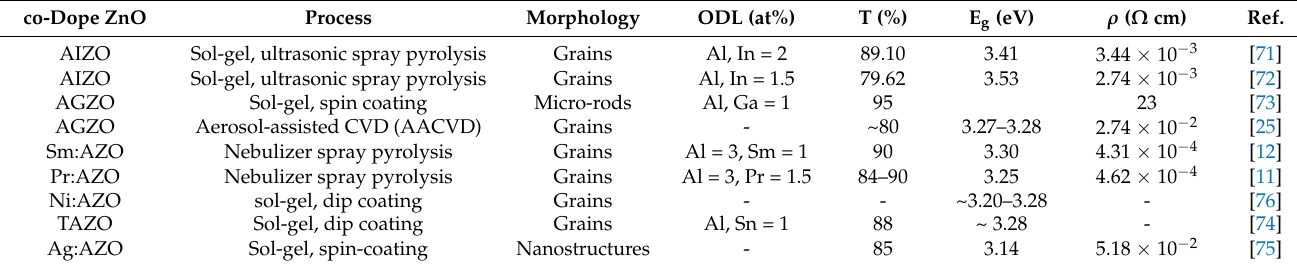
Table 2. Solution processed co-doped ZnO in different morphologies, along with their functional properties. Here, AIZO = Al, In co-doped ZnO; AGZO = Al, Ga co-doped ZnO; TAZO = Sn, Al co-doped ZnO; ODL = optimal doping level (at%) of aluminum; T = transmittance (%) of AZO in the visible region; E g = band gap (eV) of AZO; and ρ = resistivity ( Ω cm) of